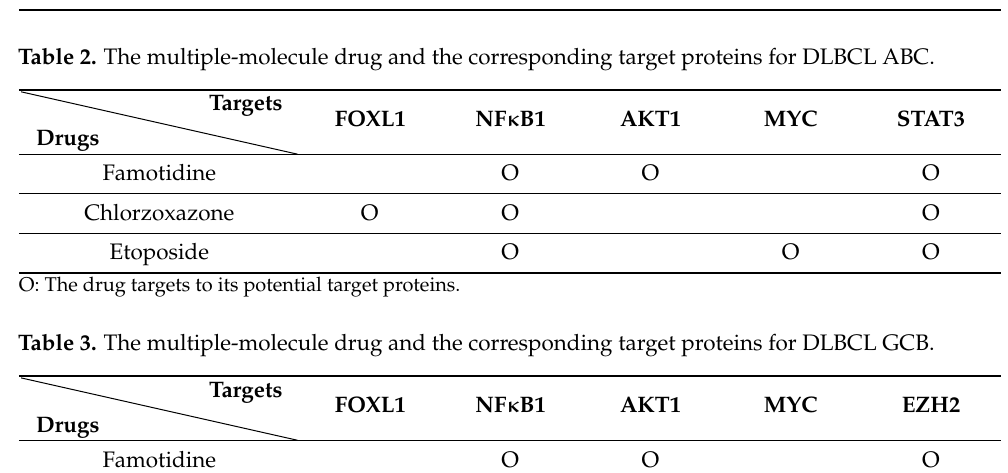
Table 2. The multiple-molecule drug and the corresponding target proteins for DLBCL ABC.